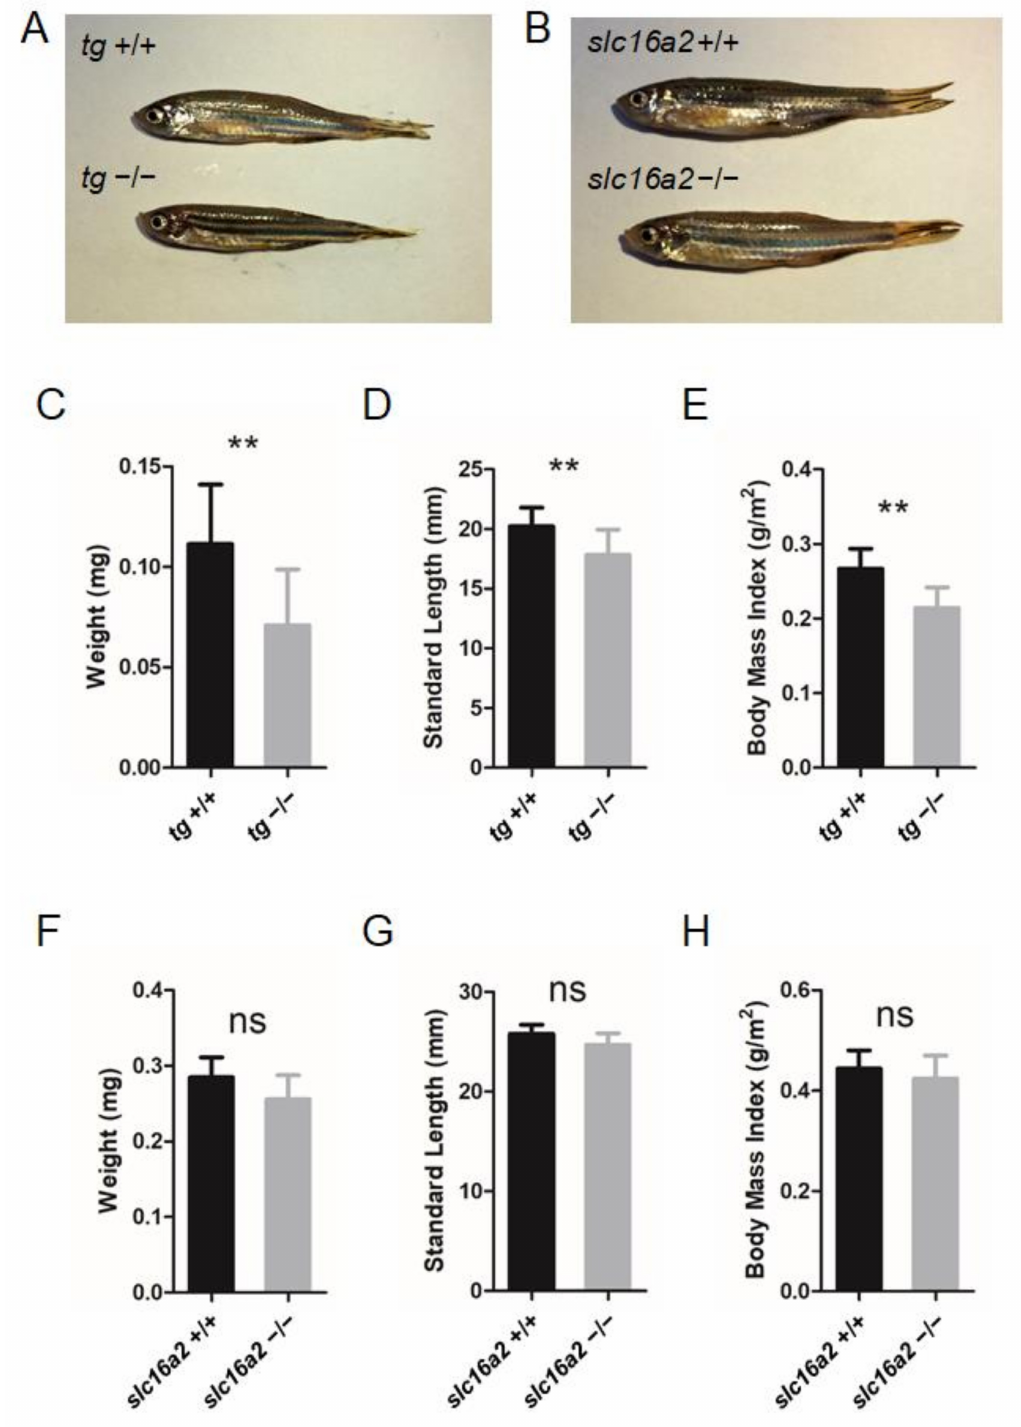
Figure 8. Somatic growth in tg or slc16a2 mutant zebrafish. ( A ) Control wild-type zebrafish and tg mutant zebrafish at 2 mpf. ( B ) Control wild-type zebrafish and slc16a2 mutant zebrafish at 2 mpf. ( C – E ) Body weight ( C ), standard length (SL) ( D ), and body mass index (BMI) ( F ) of tg mutants and their wild-type siblings at 2 mpf. Measurements were taken from wild-type fish (n = 12) and tg mutant fish (n = 13). ( F – H ) Body weight ( F ), SL ( G ), and BMI ( H ) of slc16a2 mutants and their wild-type siblings at 2 mpf. Measurements were taken from wild-type fish (n = 6) and slc16a2 mutant fish (n = 8); ** p < 0.01, ns: No